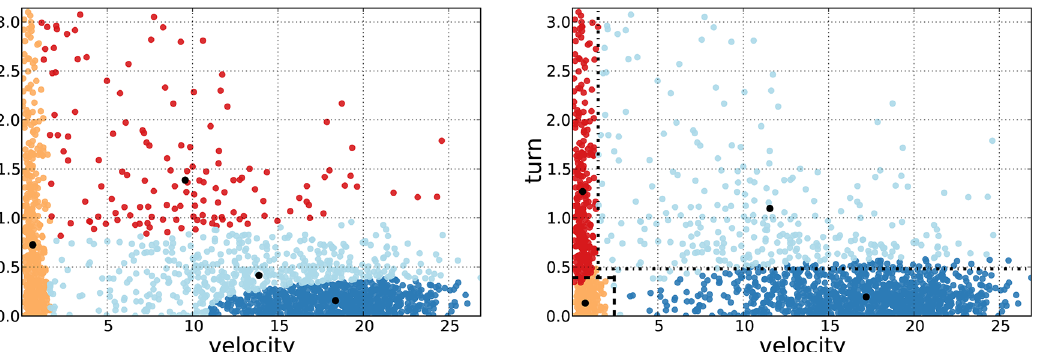
Fig 1. Cluster semantics. Comparison of the EMC (left) and EMbC (right) algorithms. Bivariate (velocity/turn) scatter-plots showing the clustering reached by each algorithm, corresponding to the same trajectory and exact initial conditions. Clusters are shown in different colours. In the right panel, the EMbC delimiters determining the final L/H binary regions are depicted as dashed lines ( r . L , r L . ) and dot-dashed lines ( r . H , r H . ). The centroids of each cluster are shown as black dots. Left: the EMC yields an output clustering that is difficult to link to a clear semantics. Right: the EMbC is driven by the delimiters, forcing the centroids to lay within the associated binary regions, yielding a final clustering that can be clearly interpreted in terms of L/H values of the variables (orange:LL, red:LH, cyan:HL and blue:HH). The matching among binary regions and clusters is not perfect because data-points are assigned to clusters depending on their weights, not on the delimiter values. In this case, the EMbC performs better (the clustering log likelihoods are -3.3368 for the EMC and -3.2180 for the EMbC), but this result can not be generalized.